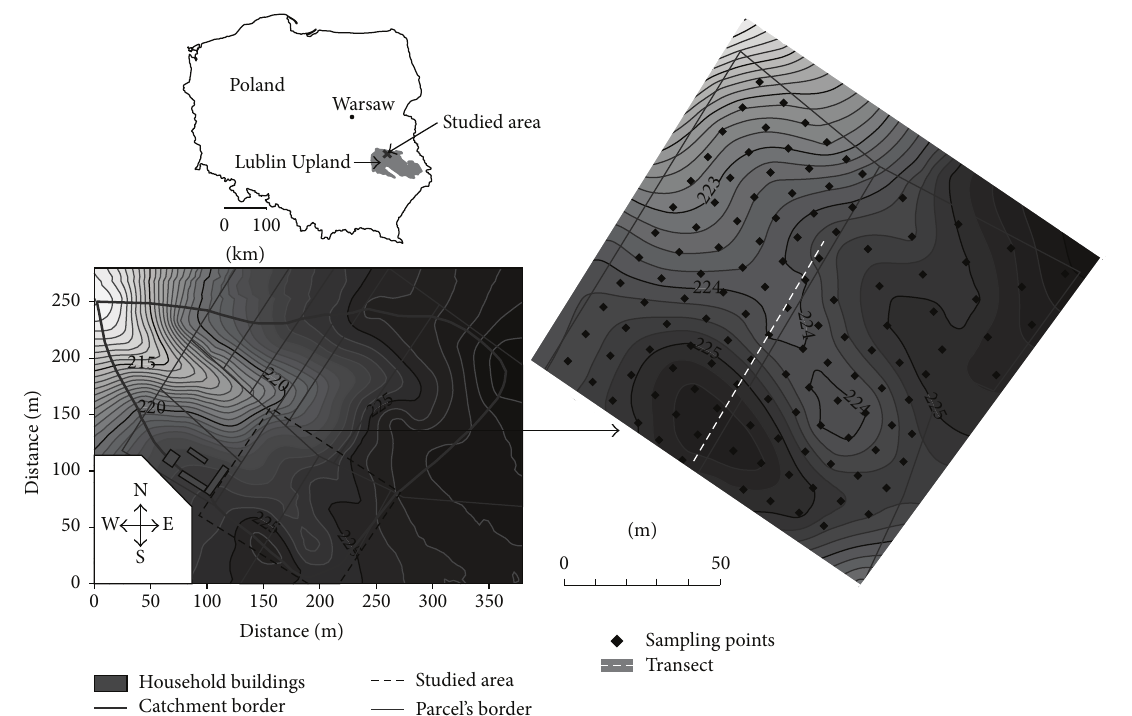
Figure 1: Location of the study area and localization of sampling points for soil profiles analyses and soil